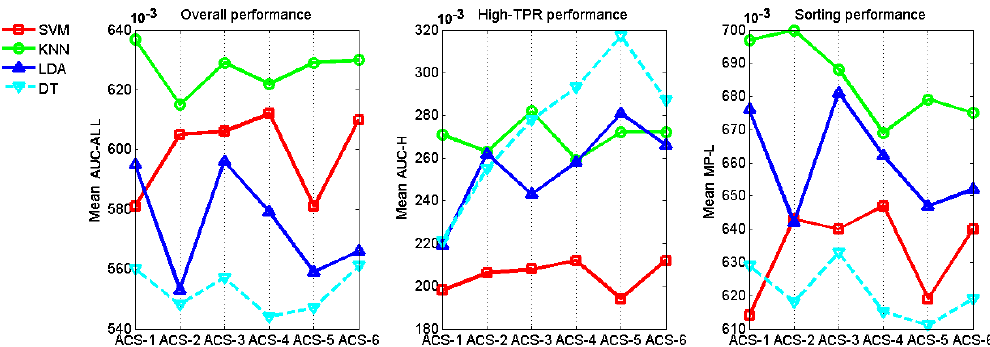
Figure 6. The mean performance values of ACS methods coupled with SVM, KNN, LDA and DT classifier. (These mean values are calculated by averaging performance values of each curve in Figure 5.)